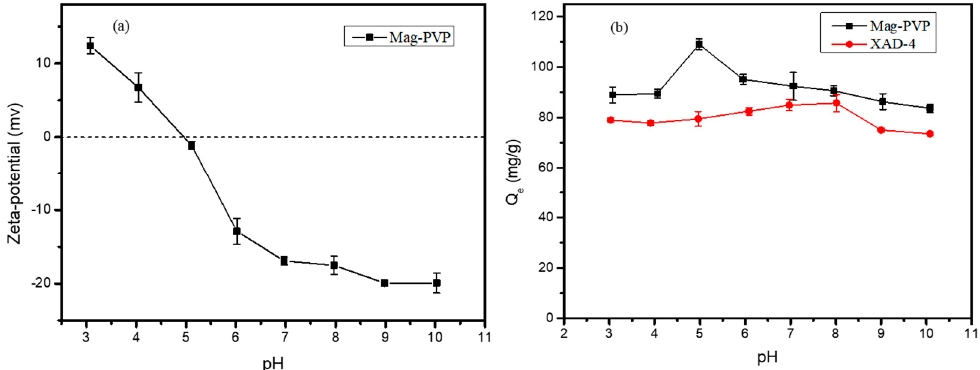
Figure 7. ( a ) Zeta-potential of Mag-PVP as a function of pH values; ( b ) Effect of pH on BPA adsorption by Mag-PVP and XAD-4 (BPA concentration = 20 mg/L; adsorbent dosage = 0.2 g/L; shaking time = 4 h). Error bars represent standard deviation values from three replicates.